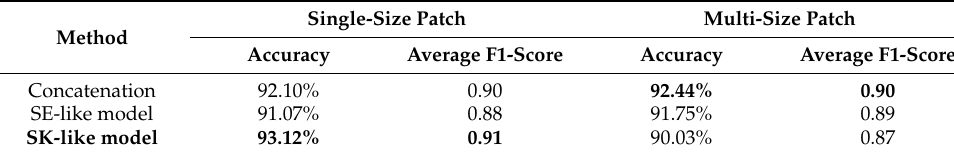
Table 2. Overall accuracy and average F1-score for different methods in test